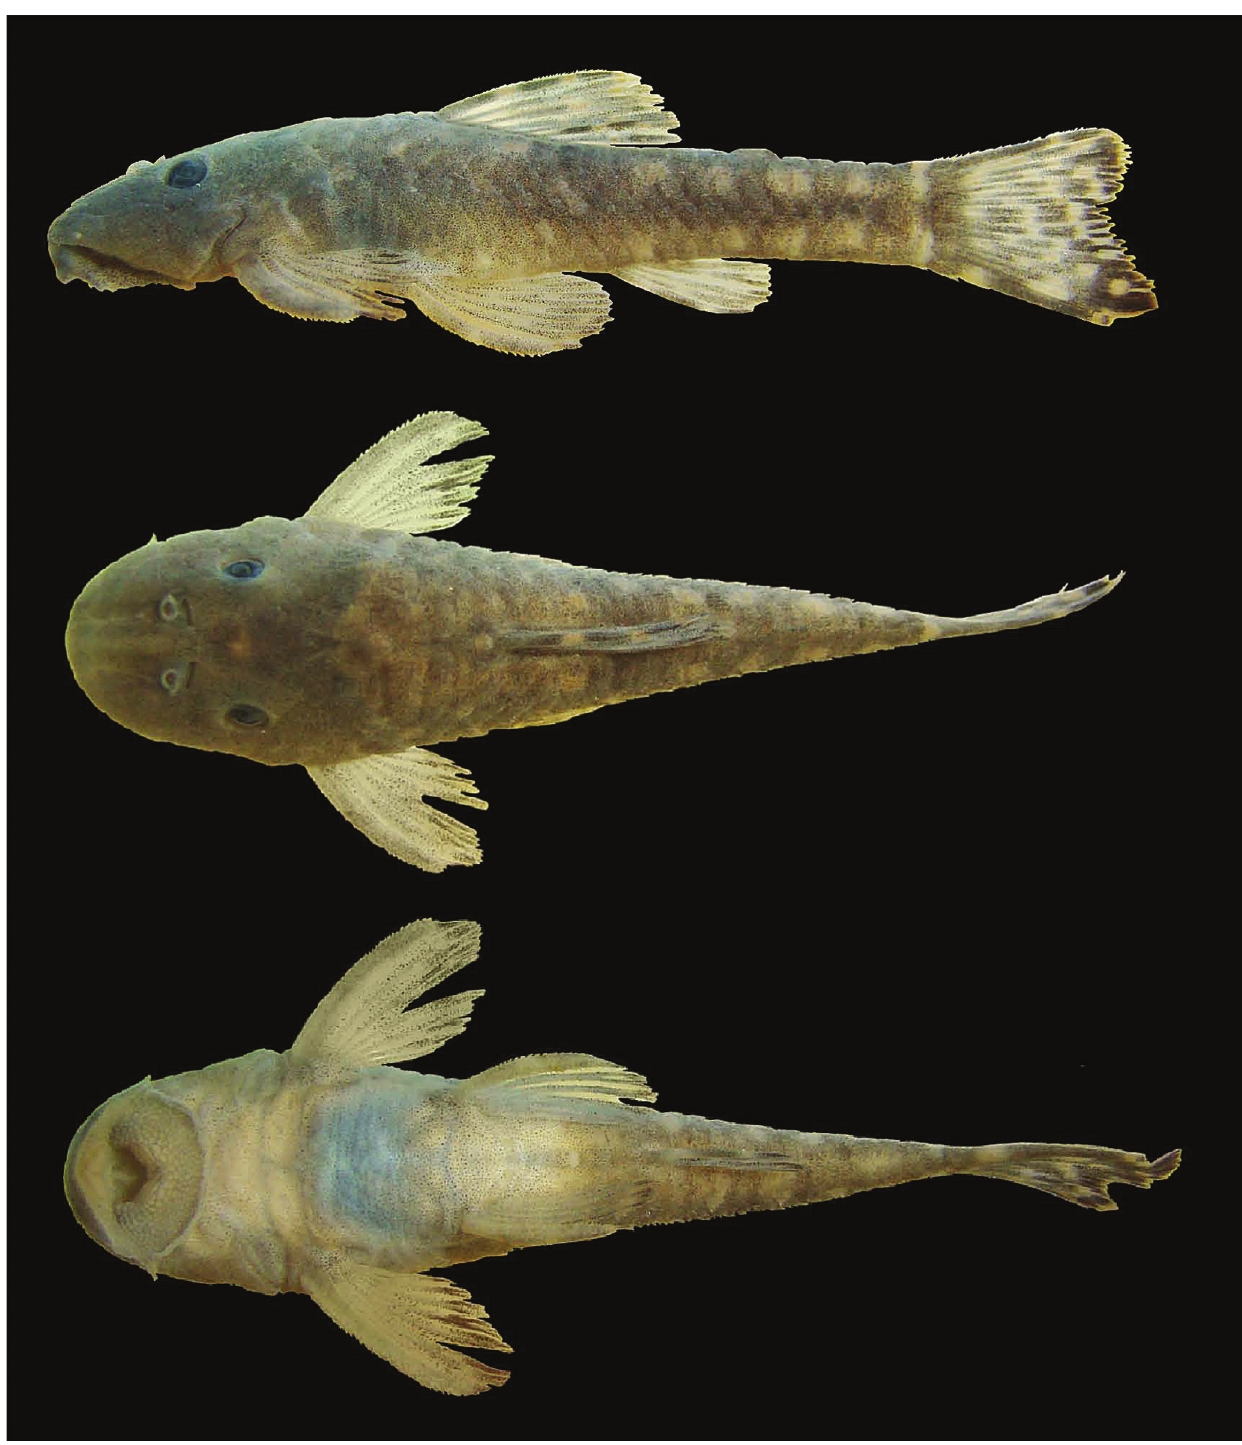
Fig. 1. Parotocinclus seridoensis , holotype, MZUSP 113422, 37.7 mm SL, female, Brazil, Rio Grande do Norte State, Caicó Municipality, rio Seridó, rio Piranhas-Açu basin. Lateral, dorsal, and ventral views.